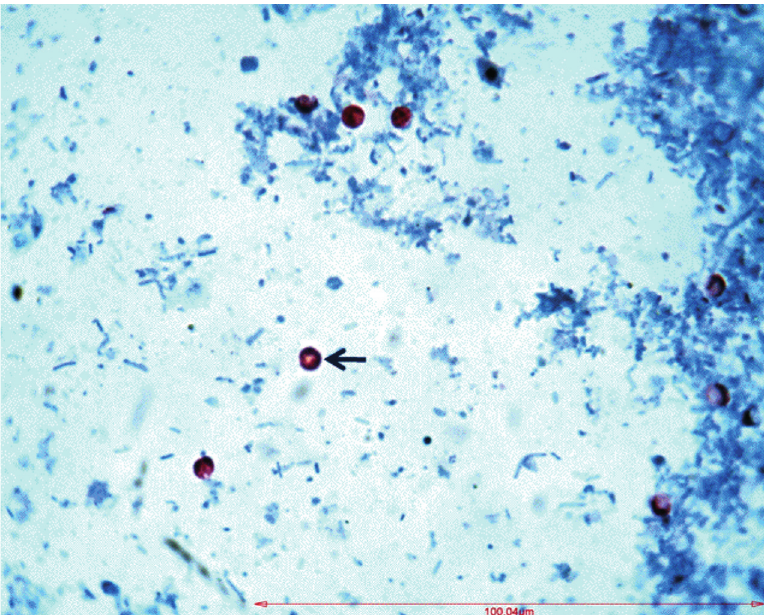
Fig. 2. – Cryptosporidium -like oocysts stained by modified Ziehl-Neelsen (MZN) method (arrow head, 1,000